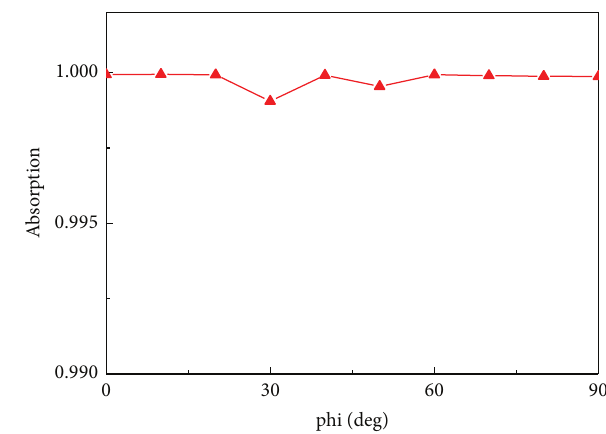
Figure 4: Simulated absorption as a function of polarization angle with step of 10 ∘ at 10.27